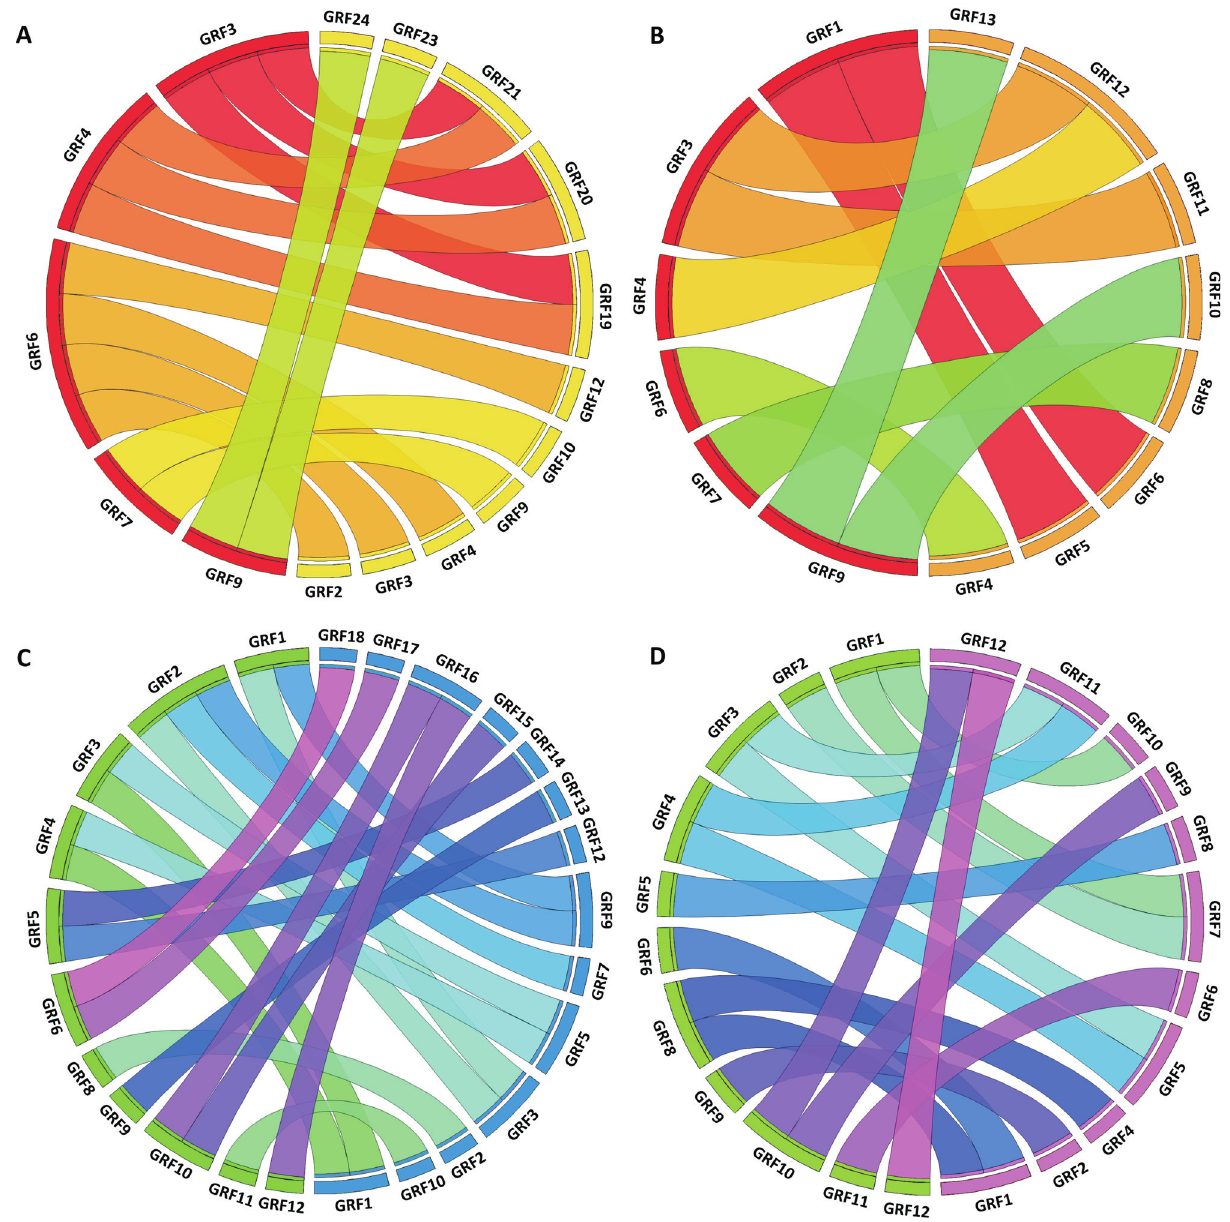
Figure7 -Syntenicanalysisof GRFs indifferentspecies.Syntenybetween(A)Arabidopsis(red)andsoybean(yellow),(B)Arabidopsis(red)andtomato (orange); (C) rice (green) and maize (blue), (D) rice (green) and purple false brome (purple). Probable orthologs are linked by